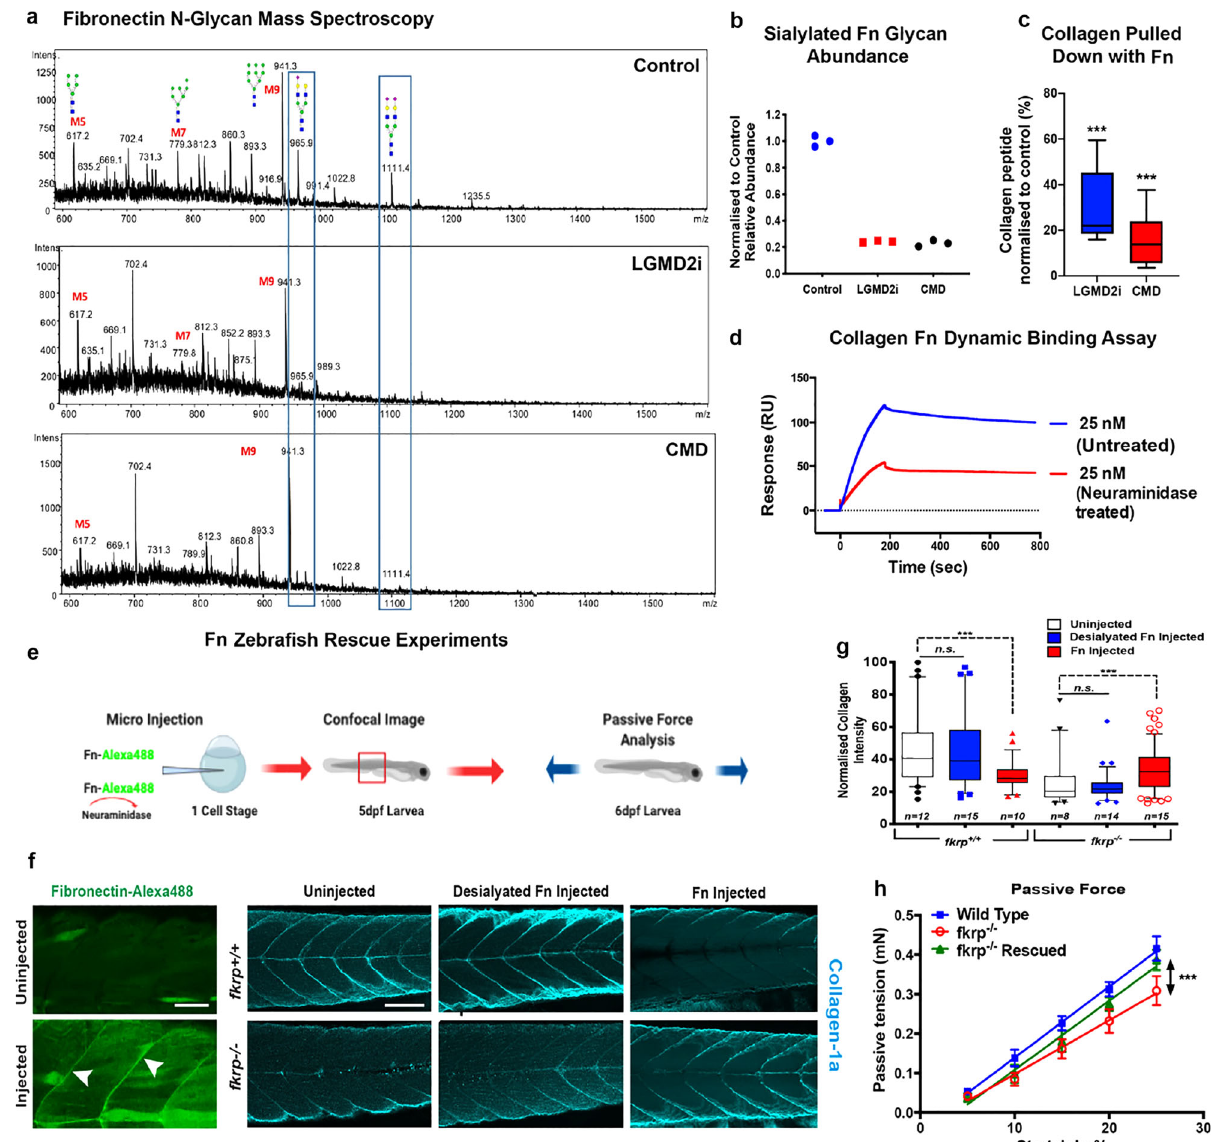
Fig. 3 FKRP-dependent N-linked sialyation of fi bronectin is required for collagen binding and muscle basement membrane localisation in vivo. a N - glycan analysis of muscle fi bronectin (Fn) isolated from control and LGMD2I and CMD patient cells. Blue box highlights the area of change at m/z 965.9 and m/z 1111.4. b Quanti fi cation n = 3 averaged from three experimental replicates, each repeated with three technical replicates (* P < 0.05). c Co- immunoprecipitation of collagen released from puri fi ed fi bronectin, normalised to healthy human controls (*** P < 0.0001); three technical repeats repeated three times, box represents 5 – 95%, median centre line, whiskers = SEM. d Collagen and fi bronectin binding quantitated via Biacore, before and after treatment with neuraminidase, an enzyme that speci fi cally removes terminal sialic acid residues. e Schematic of the fi bronectin rescue experiment. f Injection of human fi bronectin into the single-cell stage of 1-dpf embryos. Fibronectin tagged with Alexa488 localises correctly to the myosepta in wild- type larvae, white arrows. Scale bar = 100 μ m. Only fully sialylated fi bronectin can rescue collagen de fi cits evident in fkrp − / − larvae . fkrp + / + and fkrp − / − larvae uninjected or injected, with either desialylated fi bronectin or fully sialylated fi bronectin, visualised for collagen localisation via z projections of the entire mediolateral extent of the myotome centred on the anal pore. Note also that fkrp + / + control fi sh, injected with sialylated fi bronectin, exhibited a lower collagen deposition at the myoseptal boundaries. This lower collagen deposition is attributed to a previously described fi bronectin – collagen feedback loop, scale bar = 100 μ m. g Quantitation of the relative max intensity of collagen deposition at muscle basement membranes, 5 dpf, (*** P < 0.0001), plotted points outside 95% con fi dence interval analysed by two-way ANOVA, Dunn ’ s multiple comparisons, from fi ve repeats, box represents 5 – 95%, median centre line, whiskers = SEM. h Physiological rescue after fi bronectin injection. Force transducer measurement of passive tension over stretch load % ( n = 5 for each experimental condition) (*** P < 0.0001), error bars = homozygous fkrp mutants, with both forms of fi bronectin being signi fi cantly reduced compared to the fully sialylated native fi bronectin (Fig. 3d), suggesting that the decrease in fi bronectin tagged with Alexa488 dye to track localisation upon injection. In wild-type and mutant larvae, both native and desialylated sialylation may be causative of the collagen deposition de fi cits fi bronectin localised correctly to MBM boundaries (Fig. 3e). Next, evident in fkrp − / − mutants. To further test this hypothesis, fully sialylated or desialylated fi bronectin was injected into we examined collagen expression at the myoseptal boundaries